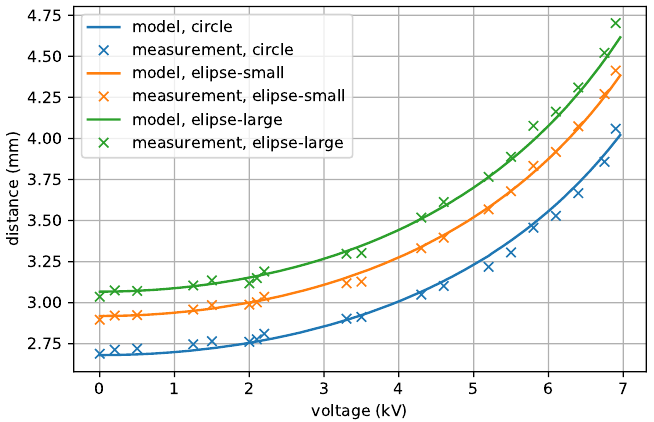
Figure 8. The static response of DEAP actuator for a mass of